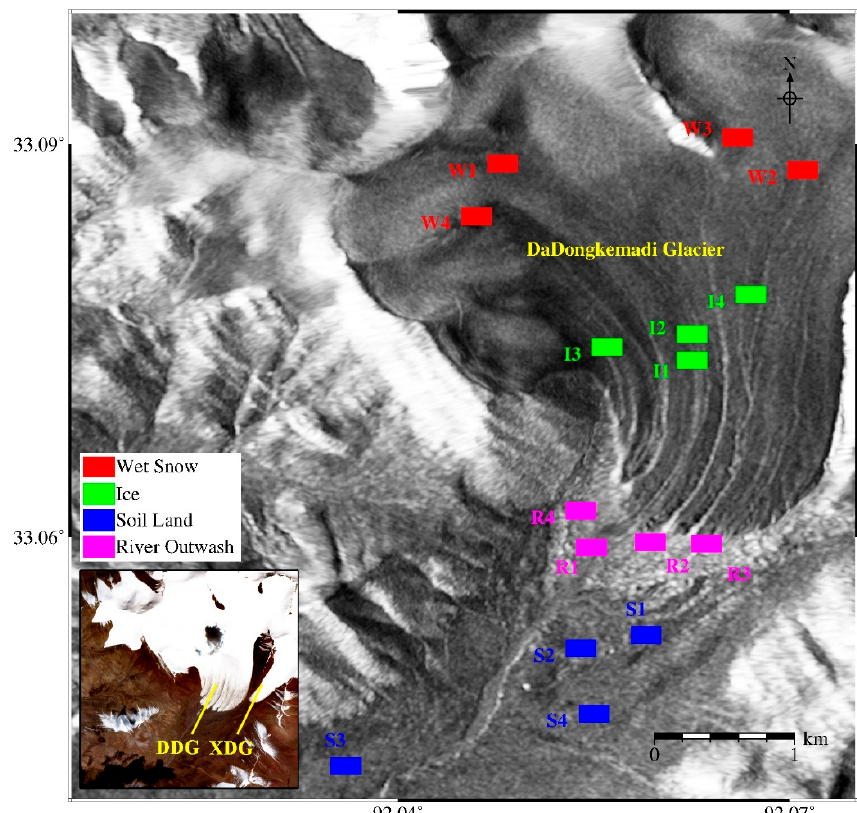
Figure 2. The exemplified patches (i.e., sampling areas) of wet snow, ice, river outwash and soil land around the DaDongkemadi Glacier (DDG), which are selected according to Huang et al. [20] and will be used in later analysis (see Section 4). The background is the geocoded synthetic aperture radar (SAR) amplitude image averaged from 45 scenes collected by Sentinel-1A (see Section 2.2). The inset in the lower-left corner shows the optical image collected by Sentinel-2B for use of later analysis (see Section 4). The four filled red, green, magenta and blue rectangles correspond to wet snow (W1–W4), ice (I1–I4), river outwash (R1–R4) and soil land (S1–S4), respectively.